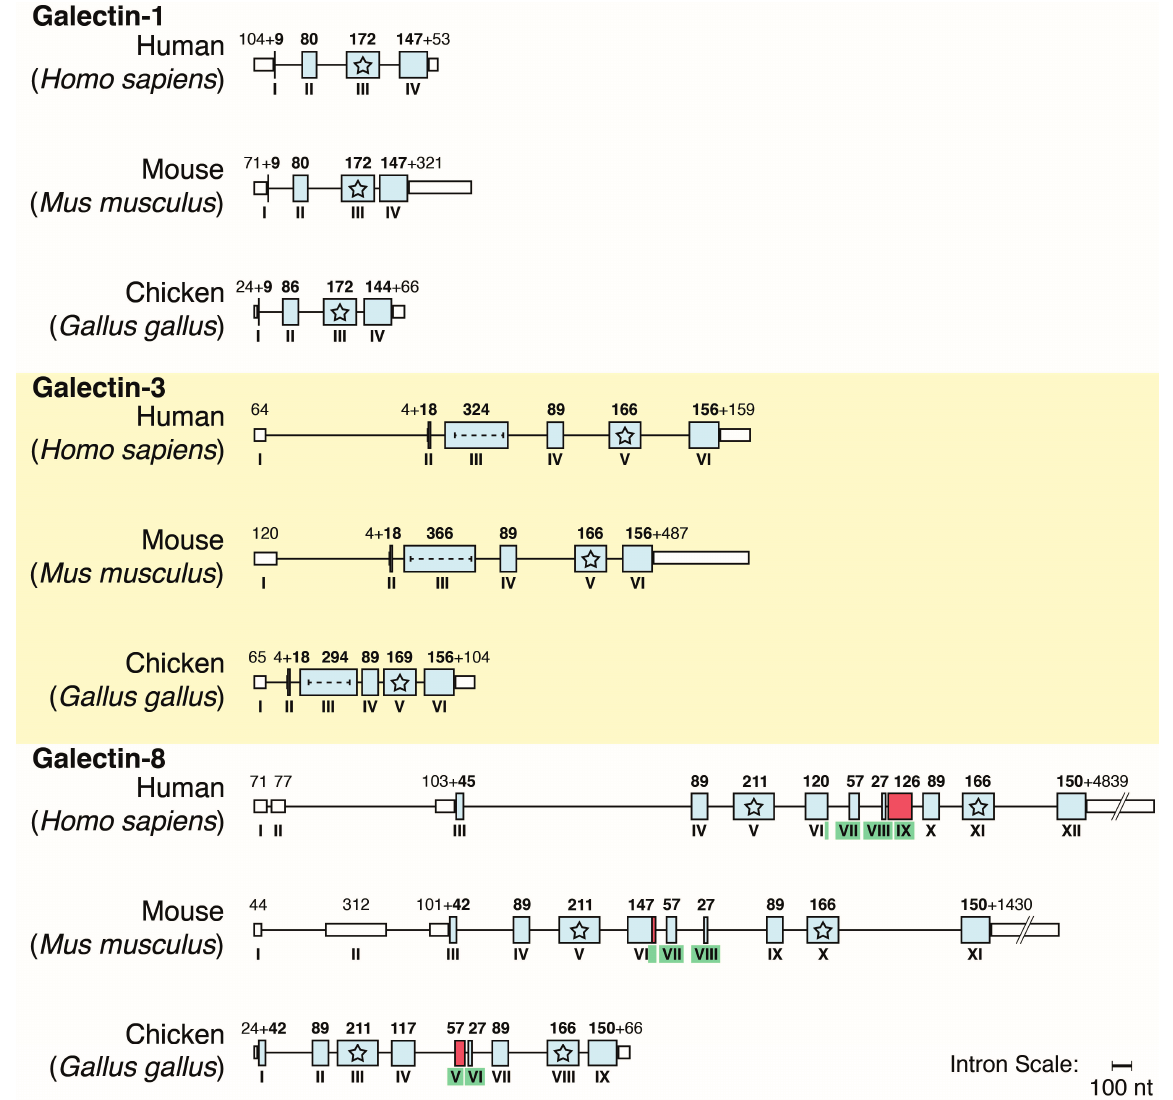
Figure 6. Phylogenetic conservation of galectin genes in vertebrates. For comparison, the structural organization of a gene from each group (Galectin-1: a proto-type protein with one CRD; Galectin-3: a chimera-type protein with one CRD attached to an N-terminal tail with a peptide and non-triple helical collagen-like repeats; Gal-8: a tandem-repeat-type protein with two different CRDs covalently connected by a linker peptide, present in two lengths due to alternative splicing) is presented, and this for man, mouse and chicken. Exons are given as boxes (colored when coding, further marked with a star when coding for the carbohydrate-binding sites), introns and 5'/3'-untranslated sequences as lines (lengths drawn in proportion). Arabic numbers provide sequence lengths, Roman numbers order of exons. The dashed line in exon III of the Galectin-3 gene depicts the repeat section, the green coloring of Roman exon numbers in the gene for Galectin-8 the coding for the linker peptide (34/76 amino acids in man, 33/42 amino acids in mouse, nine/28 in